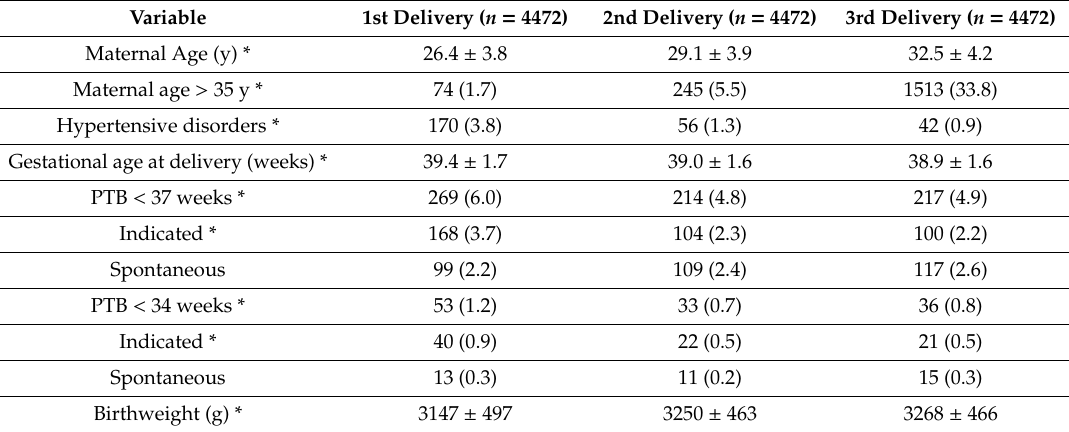
Table 1. Characteristics of the study cohort stratified by delivery order.